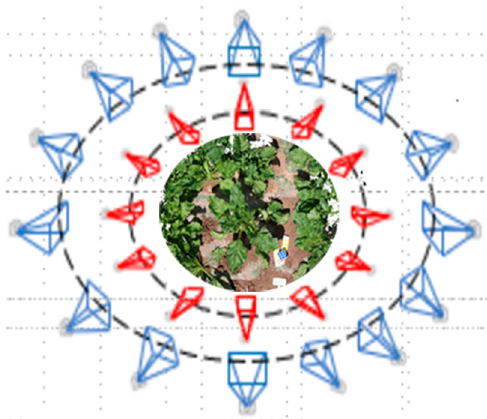
Figure 1. Camera positions for the multi-view images. Red cameras are from top view and blue cameras are from side view.